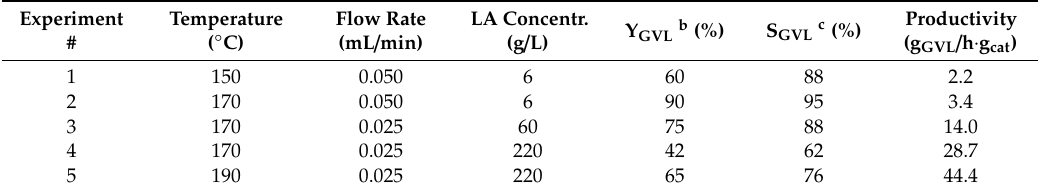
Figure 5. ( A ) Conversion and product yield profiles in the transformation of LA versus the time on the stream obtained in the packed-bed reactor charged with the bifunctional Zr–Al-Beta catalyst operating under steady-state conditions. Reaction conditions: temperature = 170 ◦ C; catalyst weight = 0.25 g; LA concentration = 220 g · L − 1 ; feed flow rate = 0.025 mL · min − 1 ; contact time = 10 min · g · mL − 1 . ( B ) LA transformation under the same reaction conditions increasing the temperature to 190 ◦ C after the in situ calcination in the air (5 h at 550 ◦ C). Table 2. Productivity of GVL in the fixed-bed transfer hydrogenation of LA using Zr–Al-Beta as catalyst a